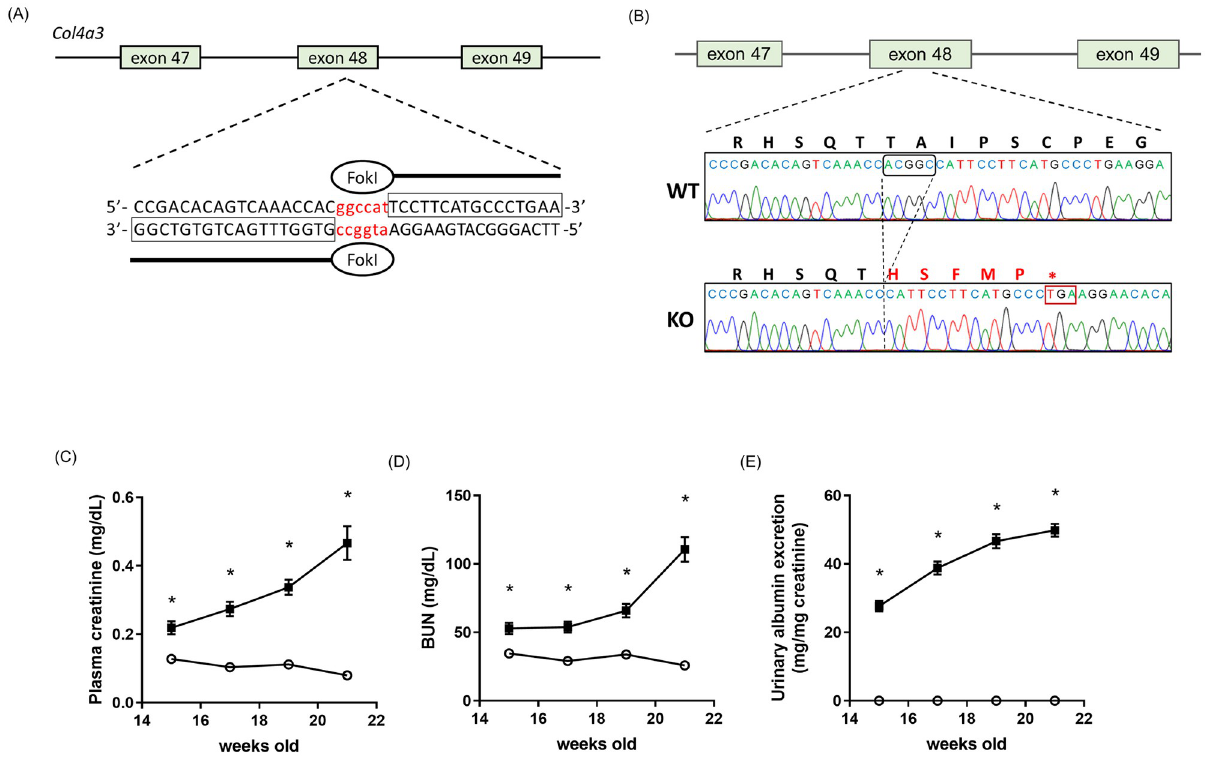
Fig 1. Generation of a Col4a3 knockout mouse strain. Schematic representation of the genomic structure of the exons 47 to 49 of mouse Col4a3 gene. ZFN binding sequences are printed in black and cutting site is printed in red. (A). Representative result of mutation analysis of the genomic PCR product by Sanger sequence analysis. WT, wild type. KO, Col4a3 knockout. Five nucleotides (ACGGC) deletion causes a premature terminal codon immediately by frame shift (B). The levels of plasma creatinine (C), BUN (D), and the urinary albumin excretion rate (E) were elevated in Alport mice. Black square indicates Alport mice and open circle indicates wild type mice as control. Data are represented as the mean ± SE (n = 5 in wild type mice, n = 8 in Alport mice). � p < 0.05, significant difference versus wild type (Student’s t-test).